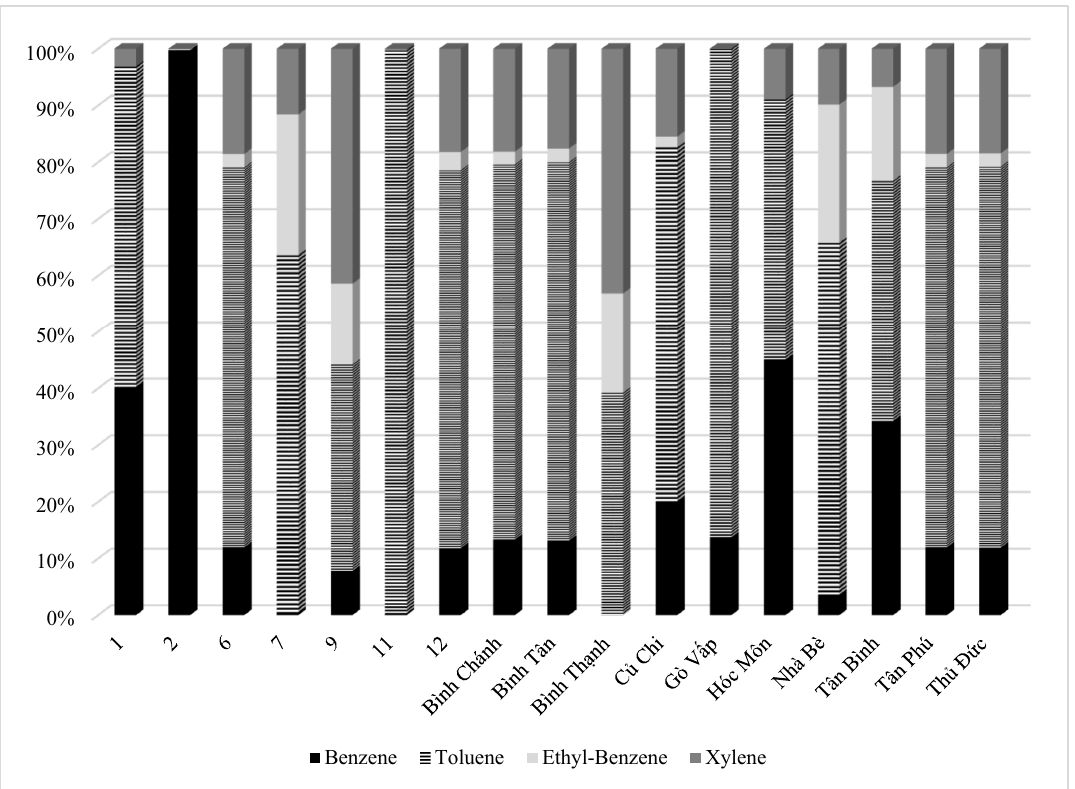
Figure 3. Contribution of BTEX emission load due to combustion fuel use and production of industry in each district in Ho Chi Minh City .